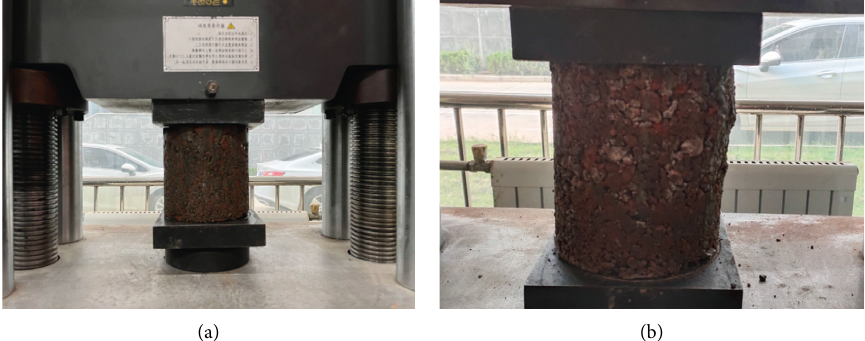
Figure 11: Unconfined compression test: (a)Unconfined compression test starts and (b)specimen is